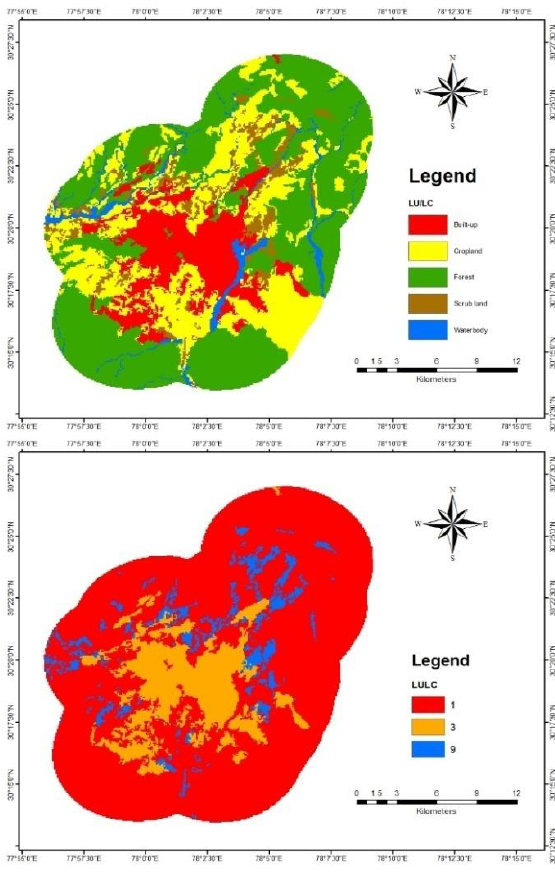
Figure 8. Suitability map according to distance from drainage